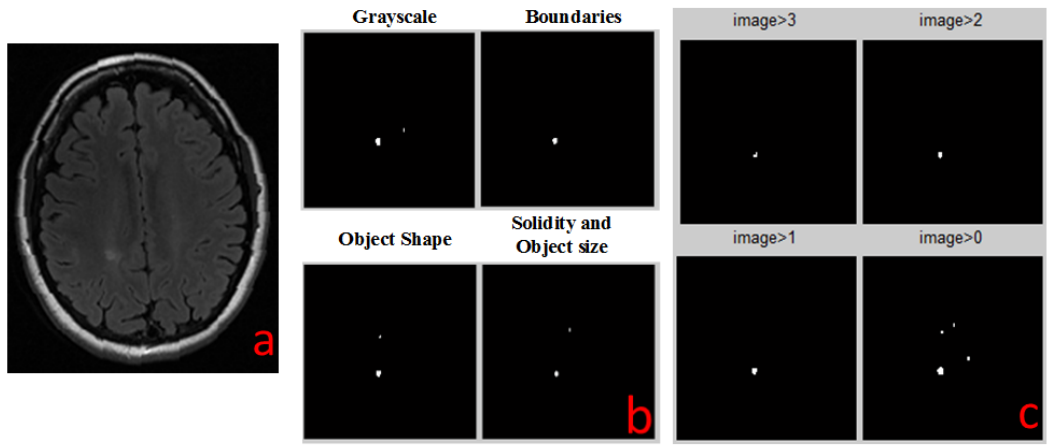
Figure 7. MS detection for image with T2_FLAIR type: ( a ) original Image; ( b ) results of all detection algorithms; ( c ) combination of all detection results, displaying pixels with value greater than a threshold value (see titles). The value of each pixel denotes the number of algorithms (out of 4) that detected this pixel as part of a positive suspected MS lesion.